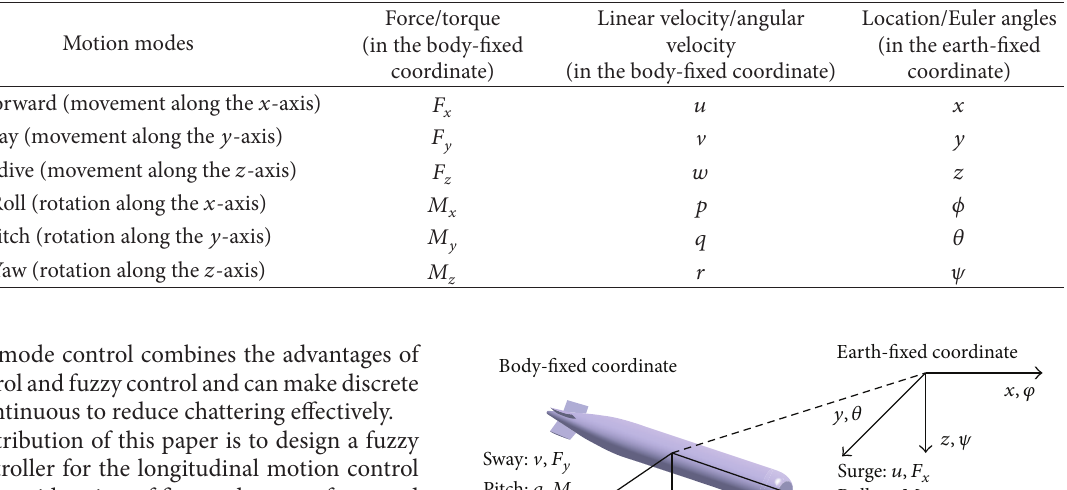
Table 1: Motion mode and attitude parameters of AUV.